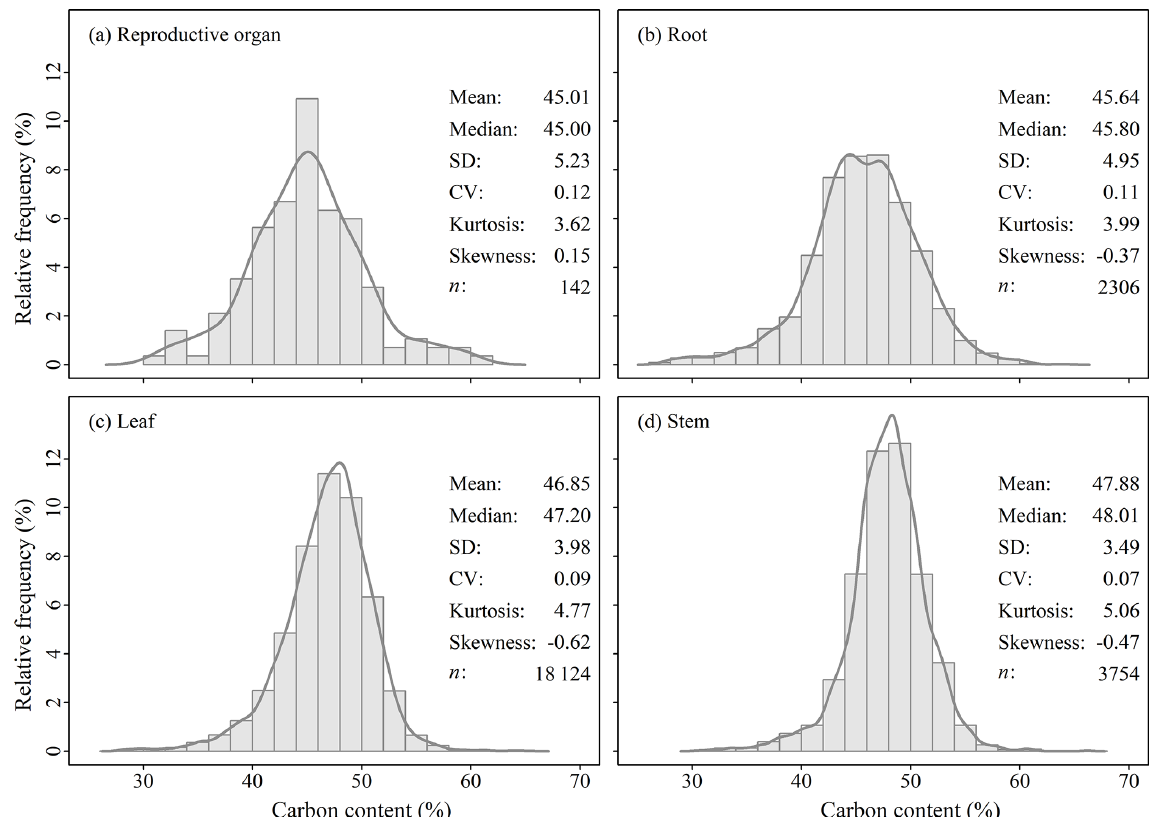
Figure 2. Histograms of carbon content of (a) reproductive organ, (b) root, (c) leaf and (d) stem. Abbreviations: SD, standard deviation; CV, coefficient of variation; n indicates sample